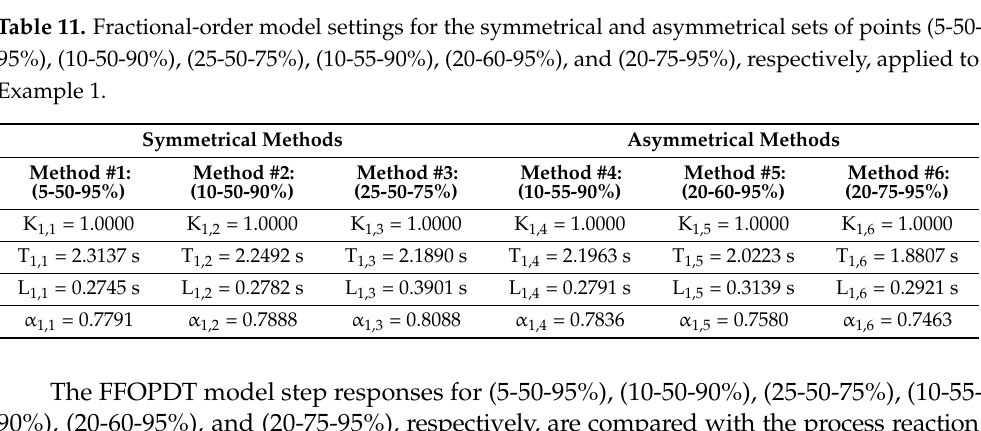
curve and illustrated in Figures 8–10. In each figure the corresponding representative points, symmetrical (x-50-(100 − x)%) and asymmetrical (x 1 -x 2 -x 3 %), respectively, are also displayed.